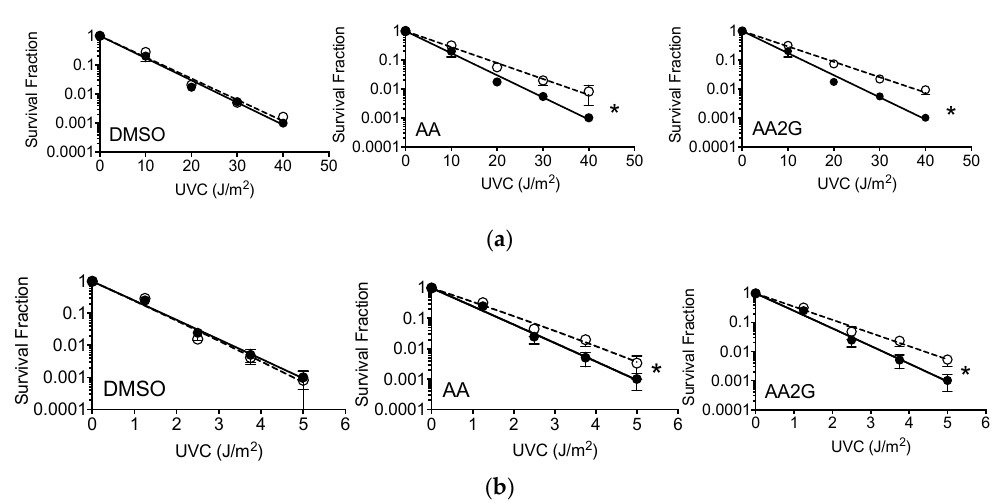
Figure 6. Cell survival curves, cells treated with DMSO, AA, AA2G before UV light exposure: ( a ) UVC exposed CHO10B2; ( b ) UVC exposed UV135. Closed circle symbols with solid lines indicate non-drug treated control. Open circle symbols with dashed lines indicate data with chemical pre-treatment. Error bars indicate standard error of the mean. * means statistically significant differences ( F -test, p < 0.05). Table 2. D 10 values and protection ratio of UVC.